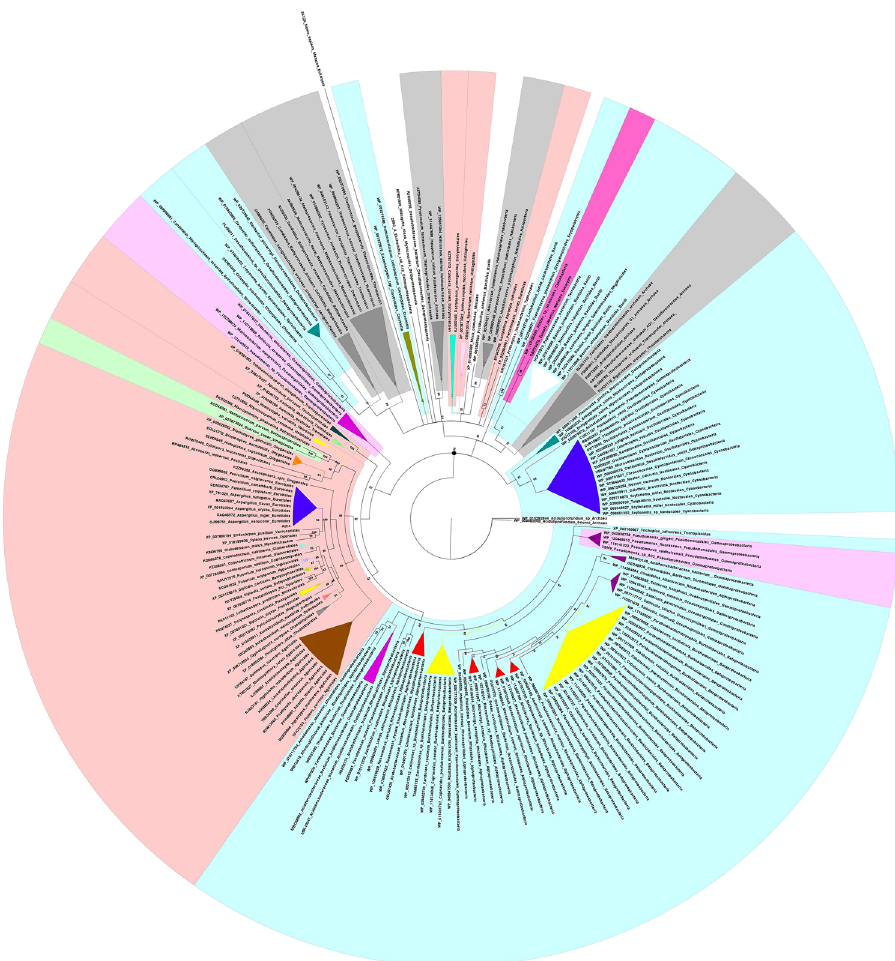
Figure 5. Phylogenetic relations of AzhA homologues in the three domains of life (Archaea, Bacteria and Eukaryotes), as emerged by the implementation of a MCMC tree, under the evolutionary model LG + G + F. All topologies produced are in agreement with the NJ analysis used as an alternative method. The tree is divided into two big clusters, which are noted with a black circle on the node that discriminates them. The coloring of the highlighted species is as follows: blue, green, grey and pink for bacteria, plants, archaea and fungi, respectively. The Aciduliprofundum spp . was used to root the tree. Tree visualization was conducted with